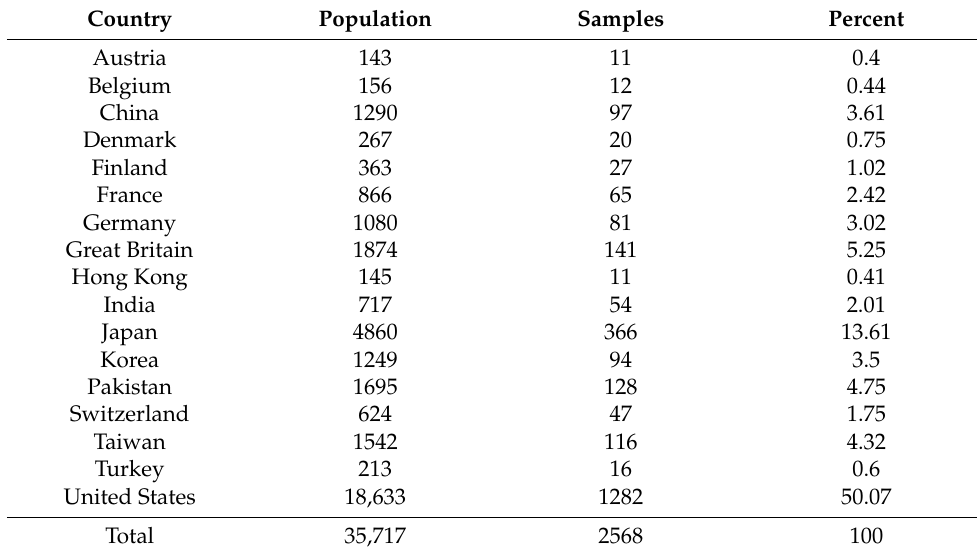
Table 1. The country-wise sample size percentages of the study.